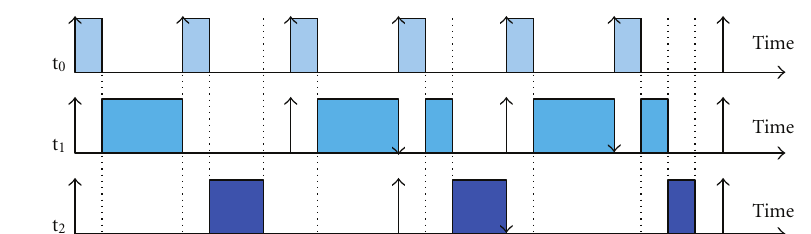
Figure 11: Example of scheduling with three tasks.